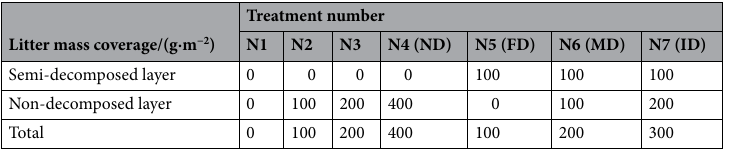
Litter mass coverage/(g·m −2